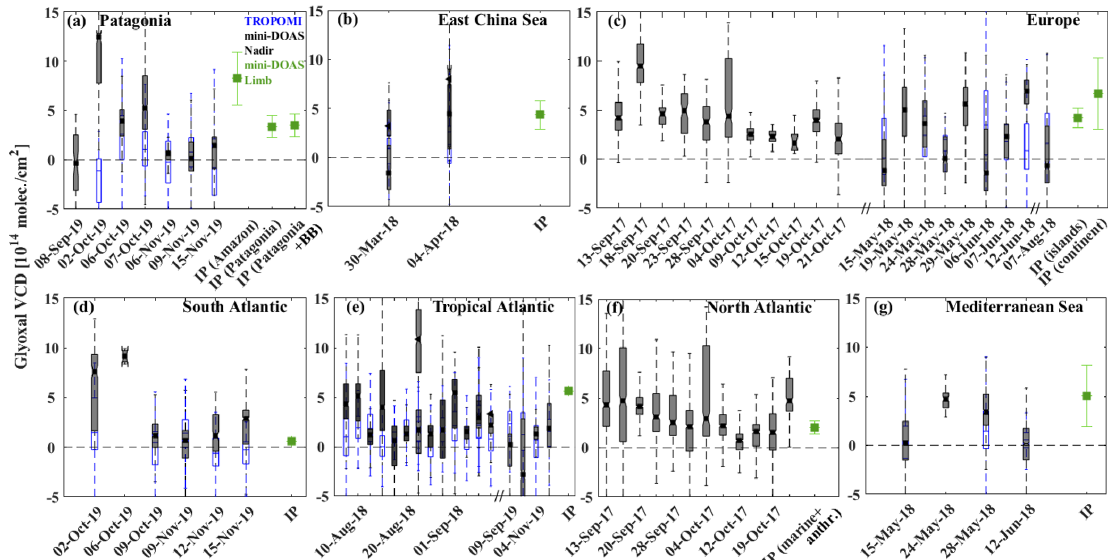
Figure 10. Comparison of inferred glyoxal VCDs for TROPOMI (blue) and mini-DOAS measurements (black) for the different regions, namely the South American continent (a) , East China Sea (b) , continental Europe and its northern islands (c) , South Atlantic (d) , tropical Atlantic (e) , North Atlantic (f) , and the Mediterranean Sea (g) . The whiskered boxes indicate the 25th to 75th percentile ranges and respective medians with in-range minima and maxima. For comparison, the integrated glyoxal limb profiles (IPs; see Sect. 4.1) for the different subsets of data (green squares) are also shown. For the South American continent, mini-DOAS VCD measurements are only available for the Patagonia and Argentina SouthTRAC deployments in fall 2019. For the measurements before 2018, TROPOMI data were not yet available.